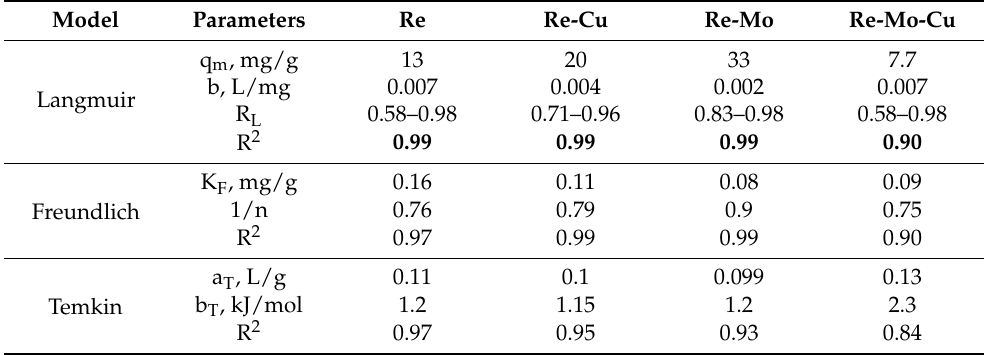
Figure 8. The adsorption isotherms and experimental data for rhenium ion sorption on yeast biomass. ( a ) Re, ( b ) Re-Cu, ( c ) Re-Mo, and ( d ) Re-Mo-Cu. Table 3. Langmuir, Freundlich, and Temkin isotherms parameters for the sorption of rhenium on yeast